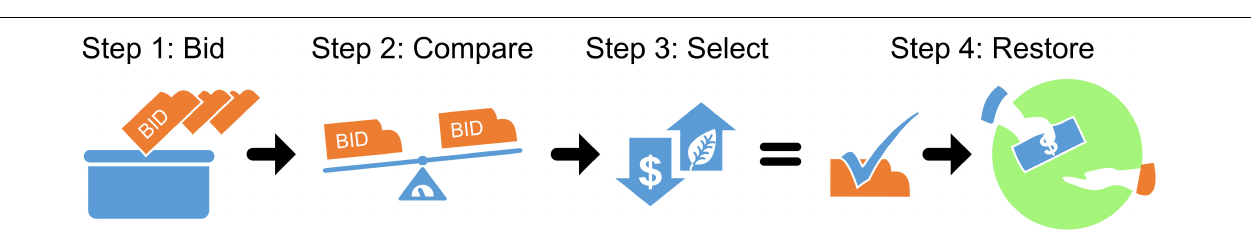
FIGURE 4 | (A) Distribution of intact and ditch-drained relative wetland value categories in the Nose Creek sub-watershed. (B) Average value and function scores in intact and ditch-drained wetlands. Human use functions were not assessed within our project.